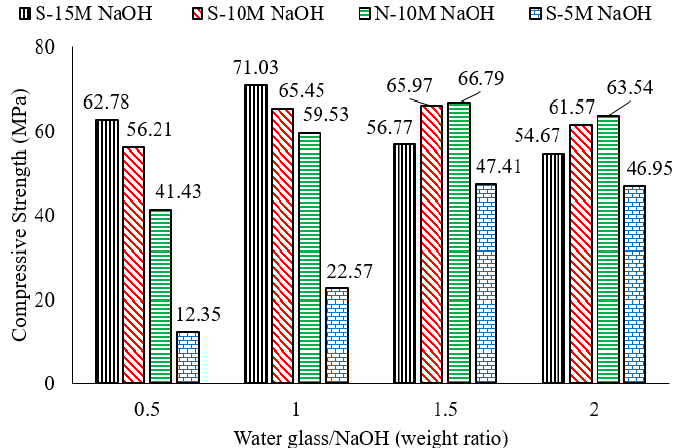
Figure 13. Variation of the mortar strength with the ratio of sodium silica/sodium hydroxide for AAF, using different mixing methods. Scheme S: fly ash mixed with NaOH for 10 min, followed by the addition of sodium silicate. Scheme N: fly ash, sodium silicate, and NaOH mixed simultaneously [76].